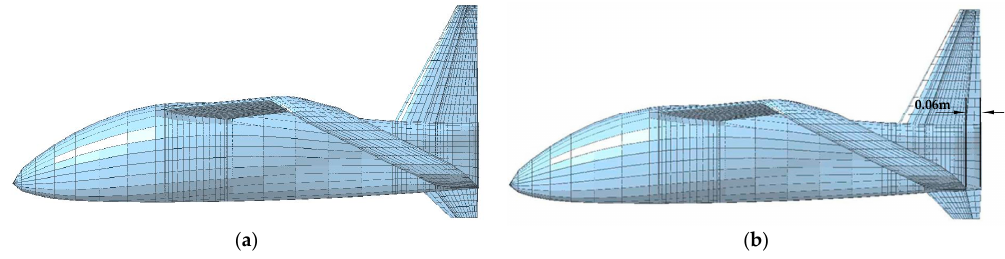
Figure 17. The airplane geometry mesh used for aerodynamic calculations: ( a ) baseline geometry; and ( b ) vertical stabilizer moved 0.06 m aft. ( b ) vertical stabilizer moved 0.06 m